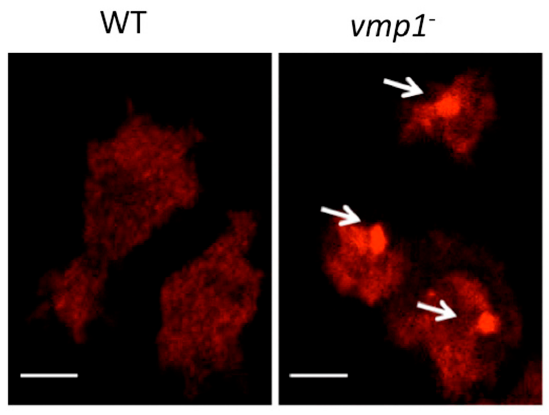
Figure 7. Detection of ubiquitinated protein aggregates by confocal microscopy. WT (AX4) and vmp1 − cells were fixed and prepared for immunocytochemistry detection of ubiquitin (red), and analyzed by confocal microscopy. Autophagy-deficient vmp1 − cells are not able to degrade proteins by autophagy and accumulate large ubiquitinated aggregates (denoted by white arrows). Scale bars 5 µm.